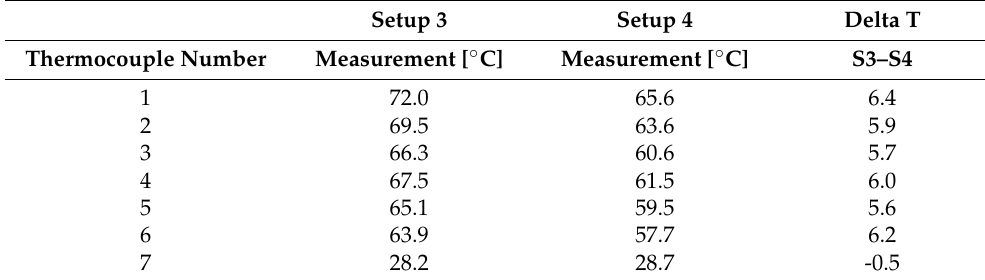
Table 7. Temperature measurements for Setup 3 and Setup